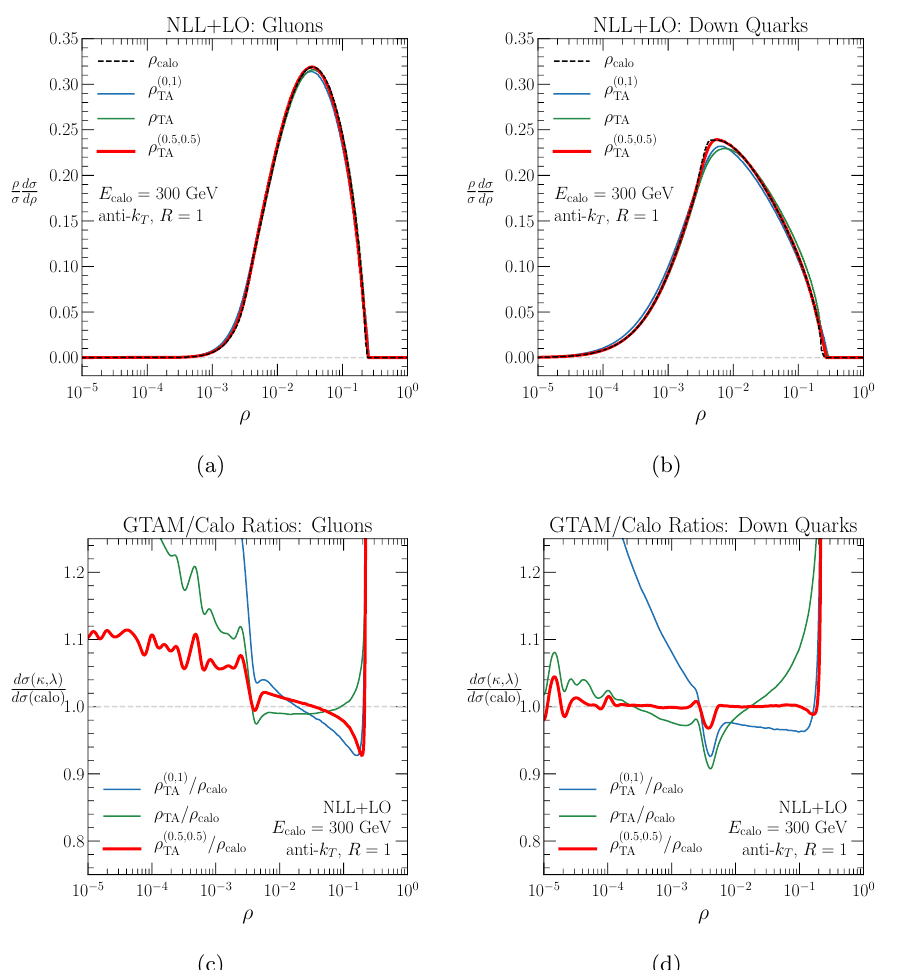
Figure 11 . Top row: NLL+LO calculations of the GTAM distribution for (a) gluon jets and (b) down-quark jets, compared to ordinary jet mass. Bottom row: corresponding ratio between GTAM and jet mass. The kink at (cid:26) few 10 (cid:0) 3 is due to freezing the coupling (cid:11) s at (cid:22) NP ’ (cid:2)